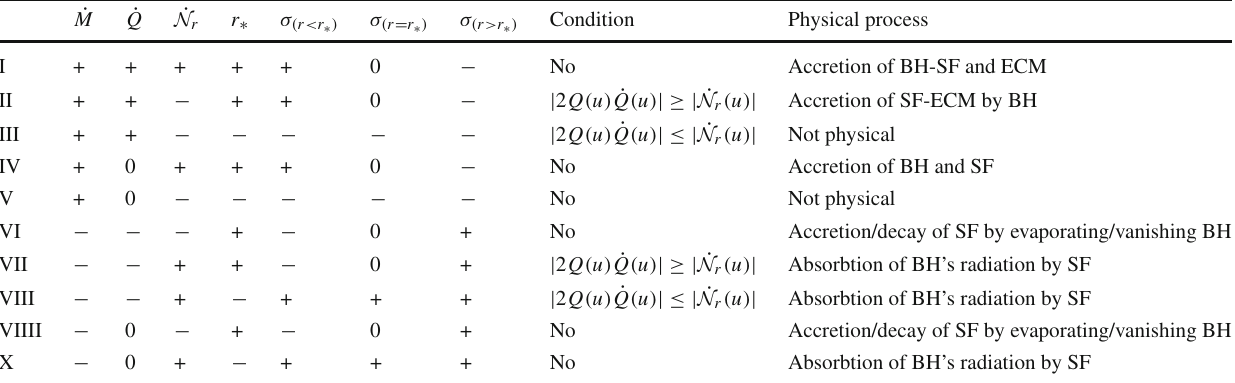
Table 3 General Bonnor–Vaidya BH and its radiation SF parameters for (cid:2) = − 1